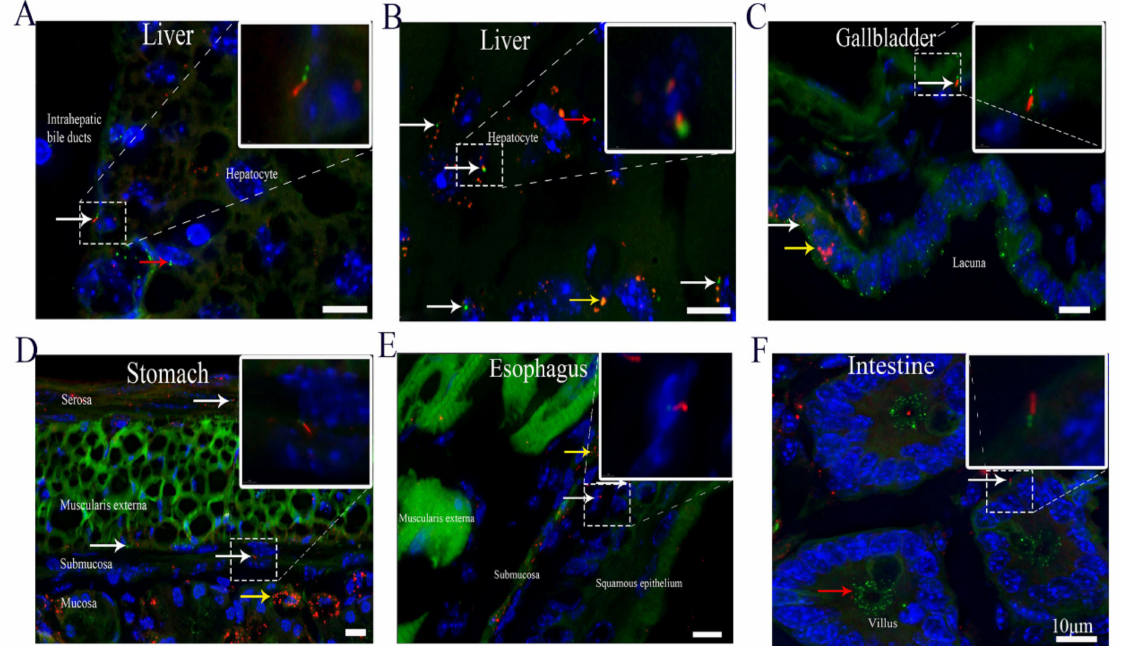
Figure 2. Cilia are present in different organs of the digestive system. ( A , B ) Hepatocytes and intrahepatic bile ducts in the liver, ( C ) gallbladder, ( D ) stomach, ( E ) esophagus, and ( F ) intestine. White arrow, cilium with an ARL13B-mCherry+ axoneme and Centrin2-GFP+ basal body. Yellow arrow, cell with only ARL13B-mCherry. Red arrow, cell with only with Centrin2-GFP. Green, Centrin2-GFP. Red, ARL13B-mCherry. Blue, DAPI. Scale bar, 10 µ